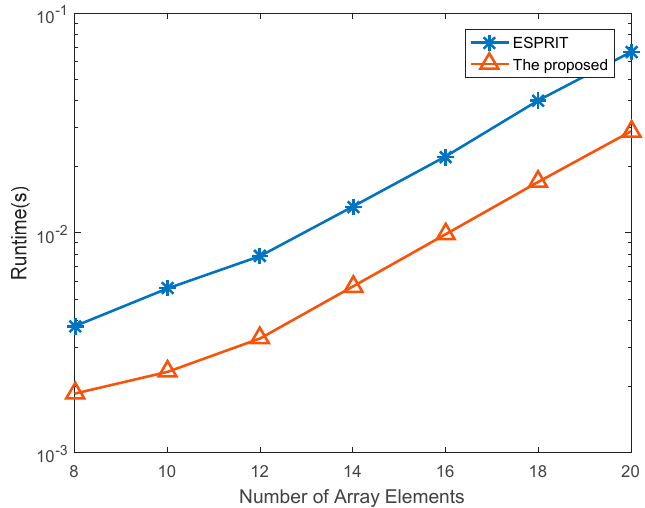
Figure 7. The runtime of the ESPRIT algorithm and the proposed algorithm with the different number of array elements.